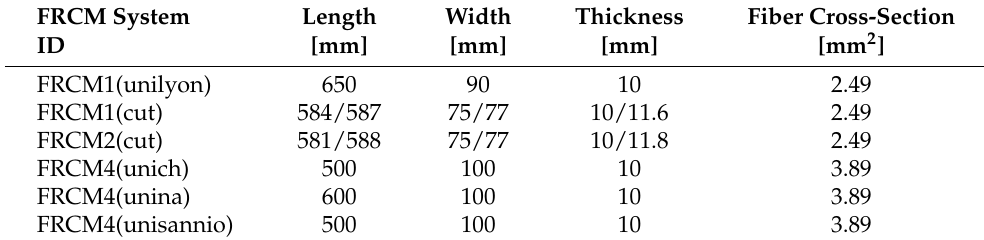
Table 2. Dimensions of the FRCM tensile